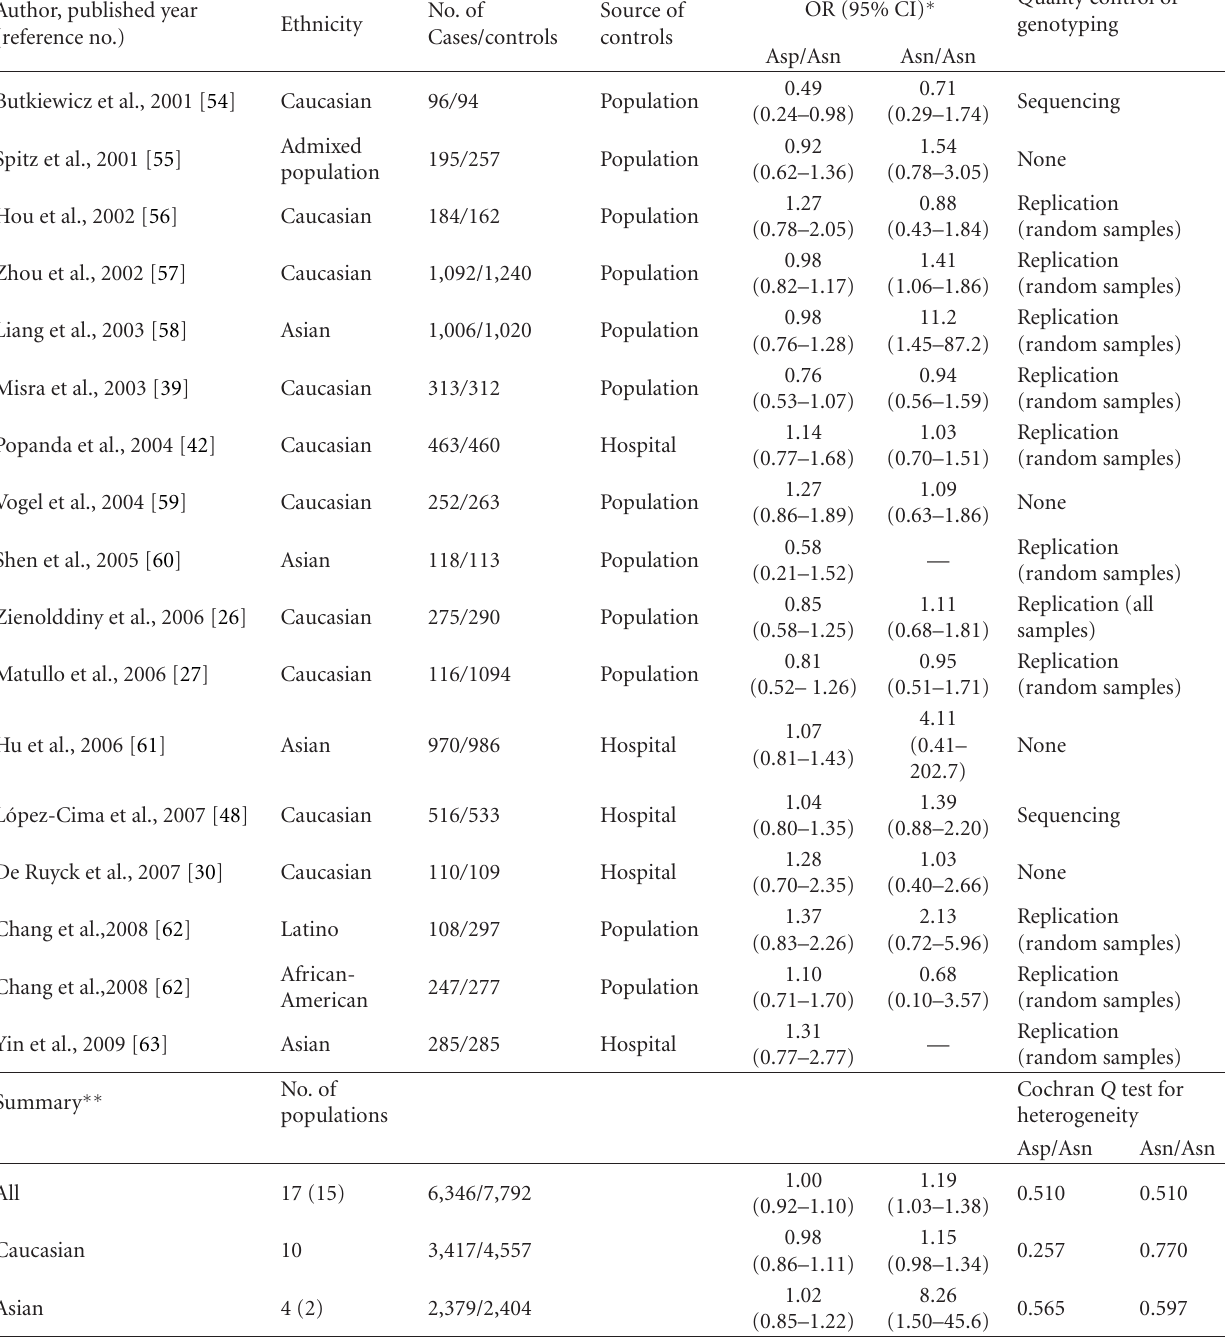
Table 7: Genetic polymorphisms in the NER pathway and lung cancer risk: ERCC2 Asp312Asn